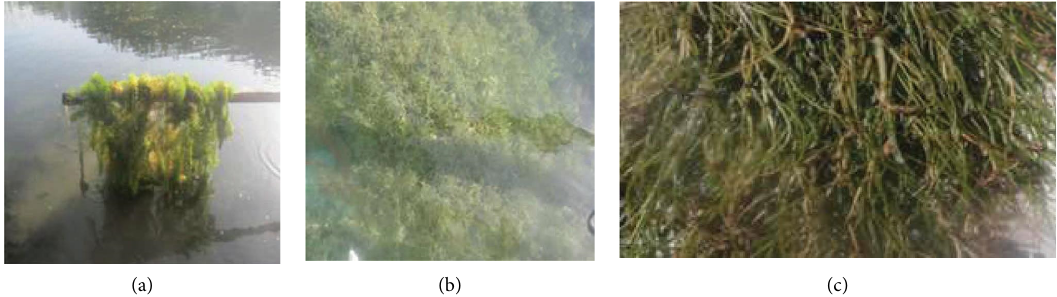
Figure 3: Invasive macrophyte species in Lake Hayq: Ceratophylum demesum (a), Ceratophylum muricatum (b), and Potamogeton pectinatus (c) (from Girum et al., 2016 )